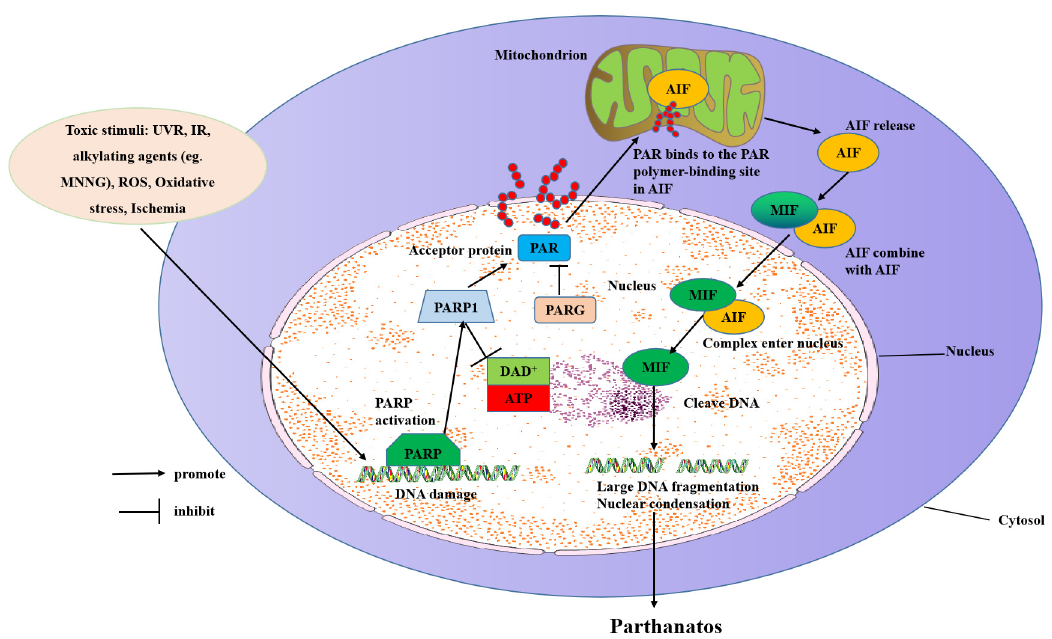
Figure 2. Molecular mechanisms of parthanatos. Toxic stimuli such as ROS, ischemia, alkylating agents (e.g., MNNG), IR, and UVR activate PARP-1 directly or indirectly through activation of NOS, which makes NO to induce ROS and the subsequent DNA damage. PARP-1 overactivation produces free PAR by PARG-mediated hydrolyzation, which serves as a death signal from the nucleus to mitochondria, inducing the release of AIF. AIF then translocates with MIF to the nucleus where it induces extensive fragmentation of DNA. This form of cell death is called “parthanatos”.